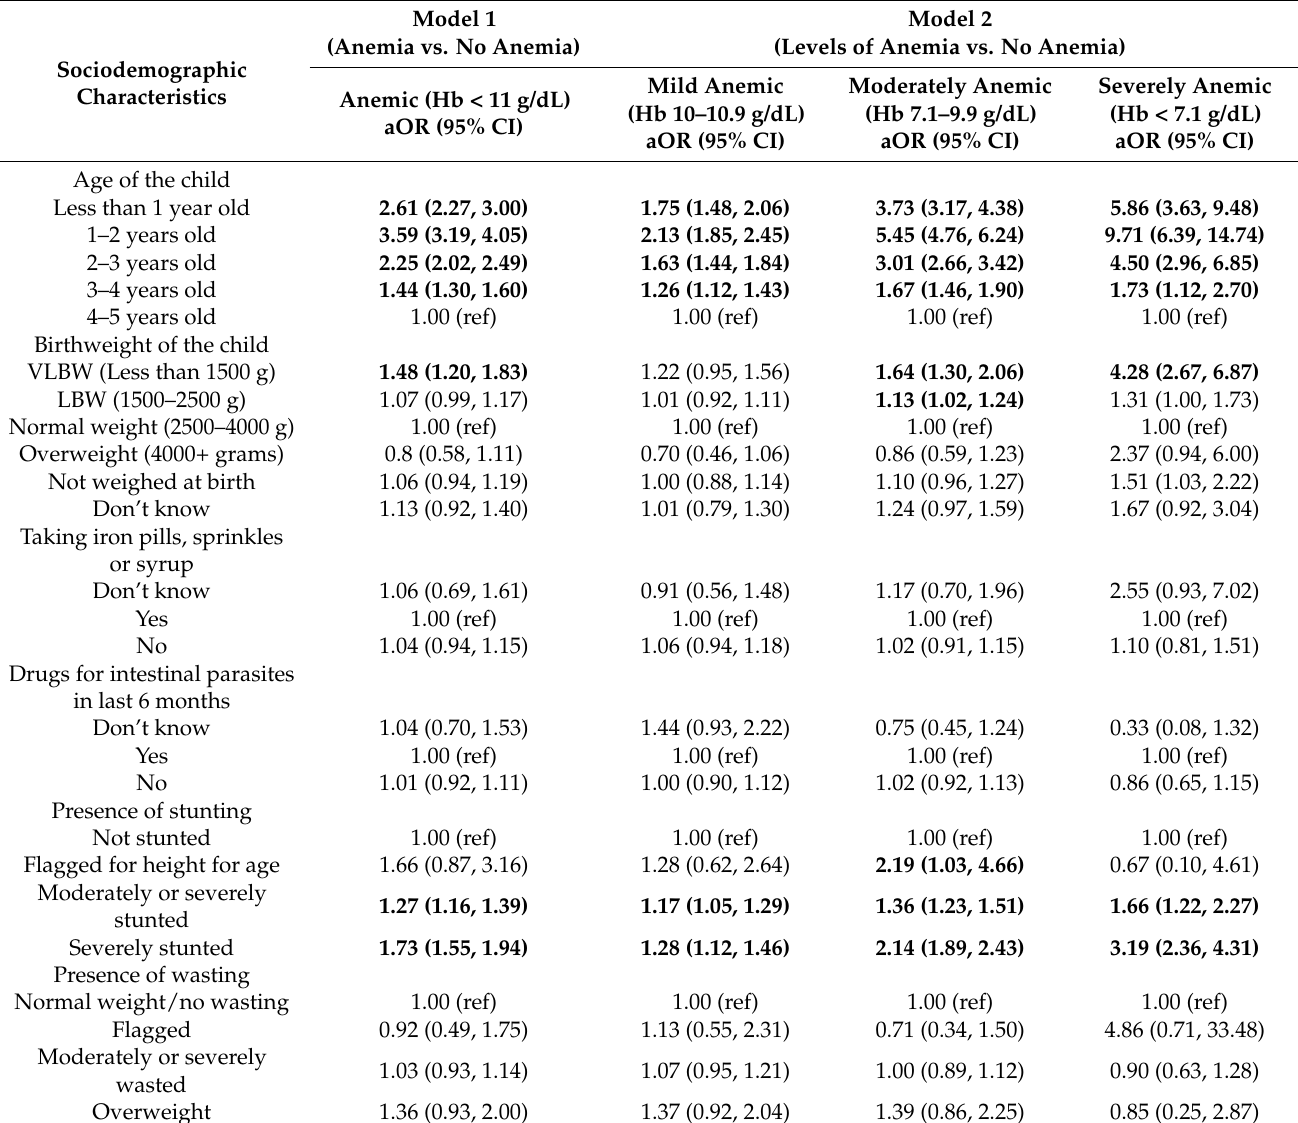
Table 4. Adjusted odds ratios (aORs) of the weighted analyses representing association of anemia in children and sociode- mographic characteristics (Model 1: Presence of anemia, Model 2: Level of